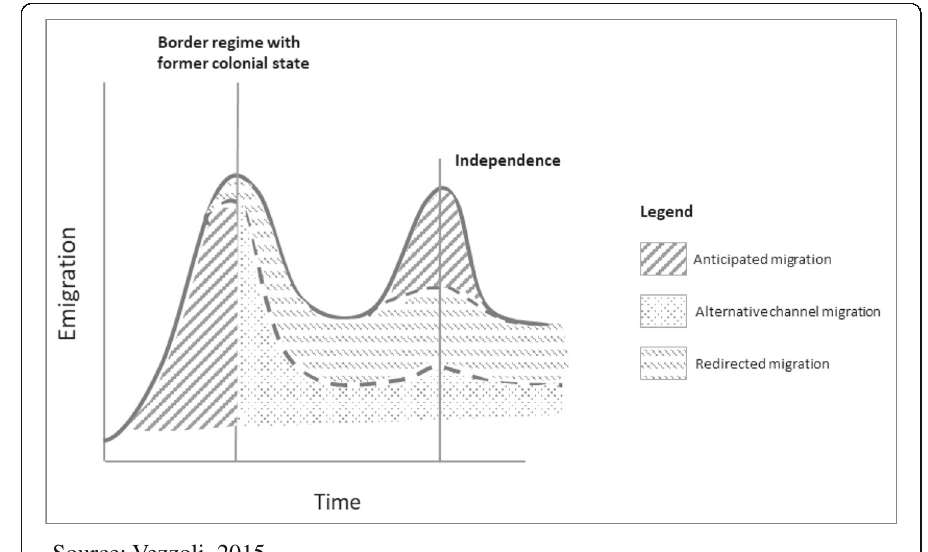
Fig. 7 Schematic representation of how establishment of a border regime followed by independence affects international